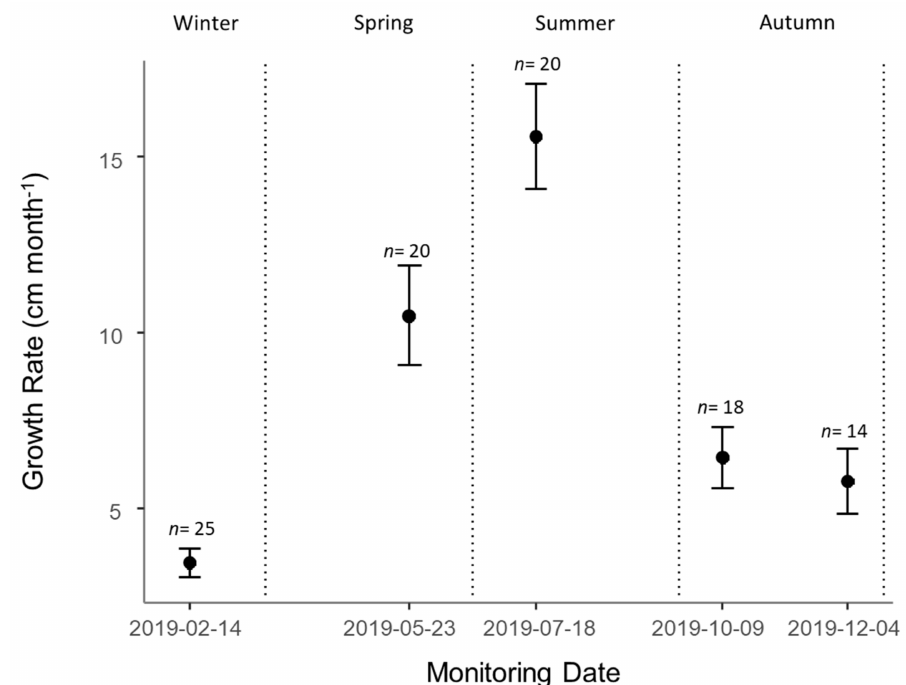
Figure 2. Average growth rate of E. globulus wildings tagged in Control plots (mean ± SE) between consecutive surveys. Dashed lines represent the limits of each